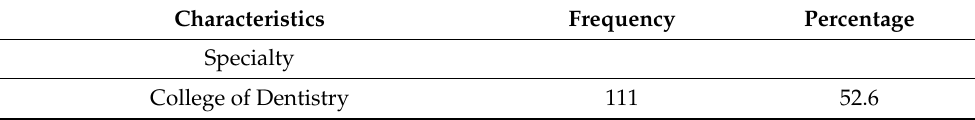
Table 1. Participants’